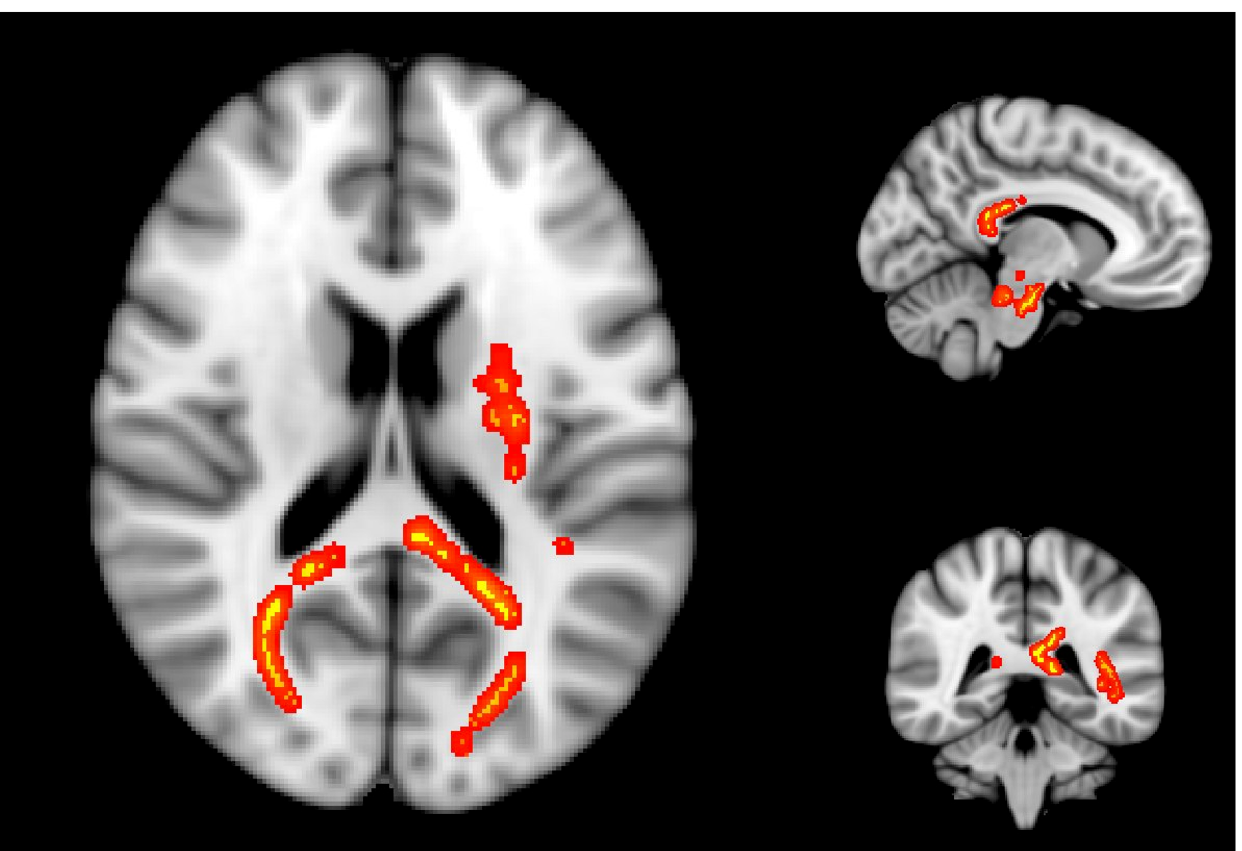
Fig 3. Brain areas with significantly reduced myelin water fraction. Areas of significantly reduced myelin water fraction in athletes with concussion at two weeks post-injury, superimposed on a standard brain. These areas include the splenium of the corpus callosum, right posterior thalamic radiation, left superior corona radiata, left superior longitudinal fasciculus, and left posterior limb of the internal capsule.